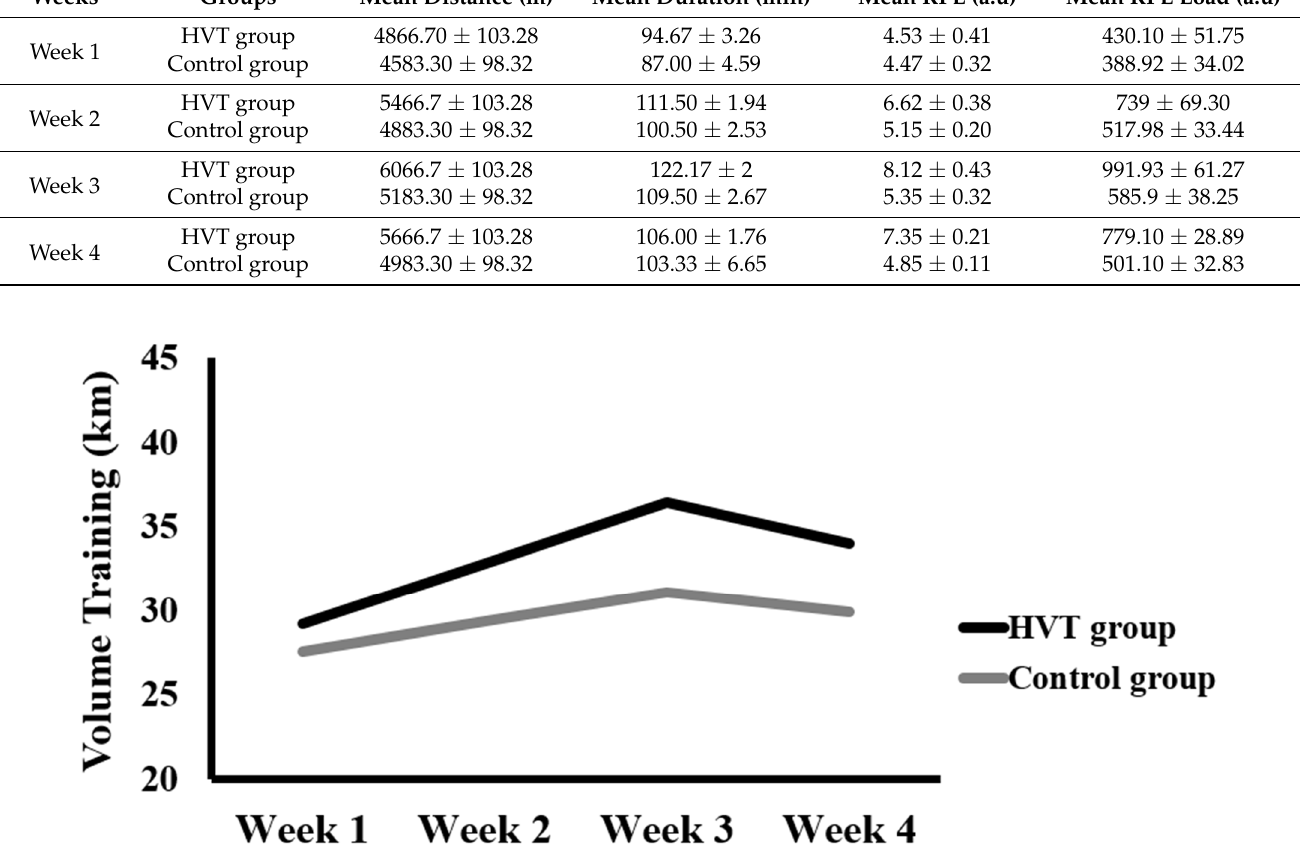
Figure 1. Volume training during four weeks of intervention period in both groups. HVT: High volume training.